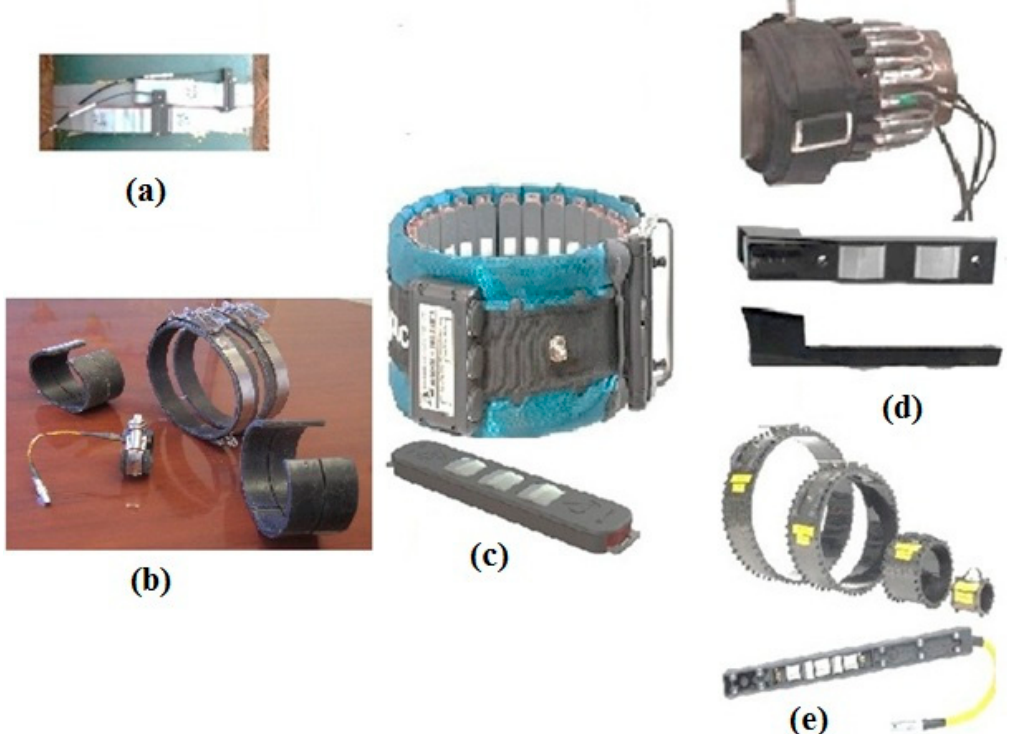
Figure 9. Commercially available collar and its transducers: (a) a US-based MsSR3030 transducer (Guided Wave Analysis LLC, San Antonio, TX, USA) [177]; (b) a set of magnetostrictive transducers made for high temperatures [168]; (c) a UK-based collar and its transducers (Guided Ultrasonics Ltd., London, UK) [178]; (d) a Japan-based collar and its transducers (Olympus Co., Tokyo, Japan) [179] and (e) a UK-based collar and its transducers ( Teletest ® Focus, Cambridge UK) [180].